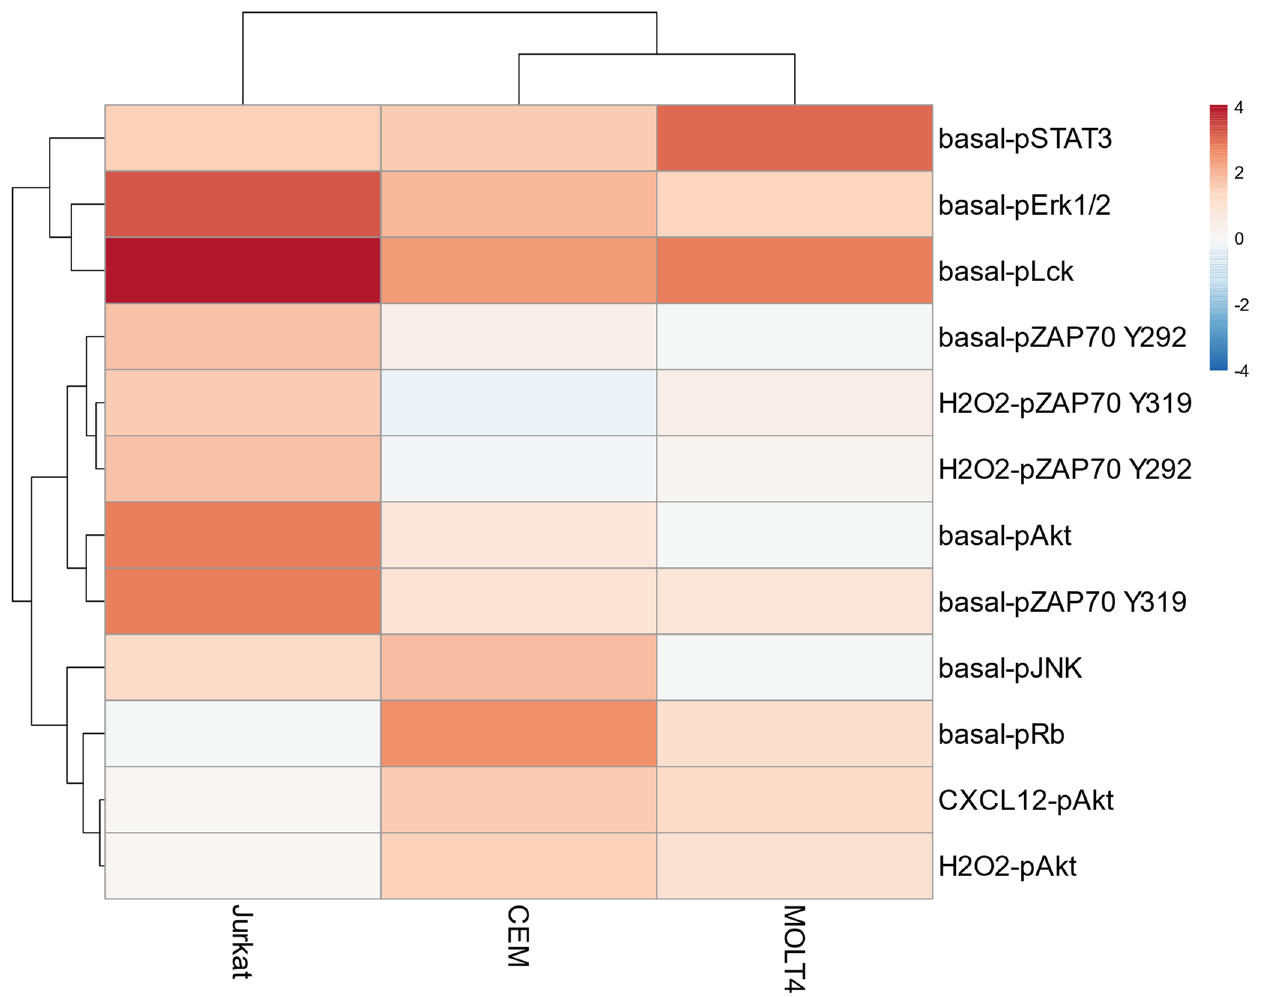
Figure 4. Unsupervised hierarchical clustering analysis on selected nodes. Unsupervised hierar- chical clustering analysis of nodes showing higher variation ( σ 2 of log 2 values > 0.5; n = 12) across samples within the T-ALL cell lines CEM, MOLT4, and Jurkat. Data are representative of three in- dependent experiments.